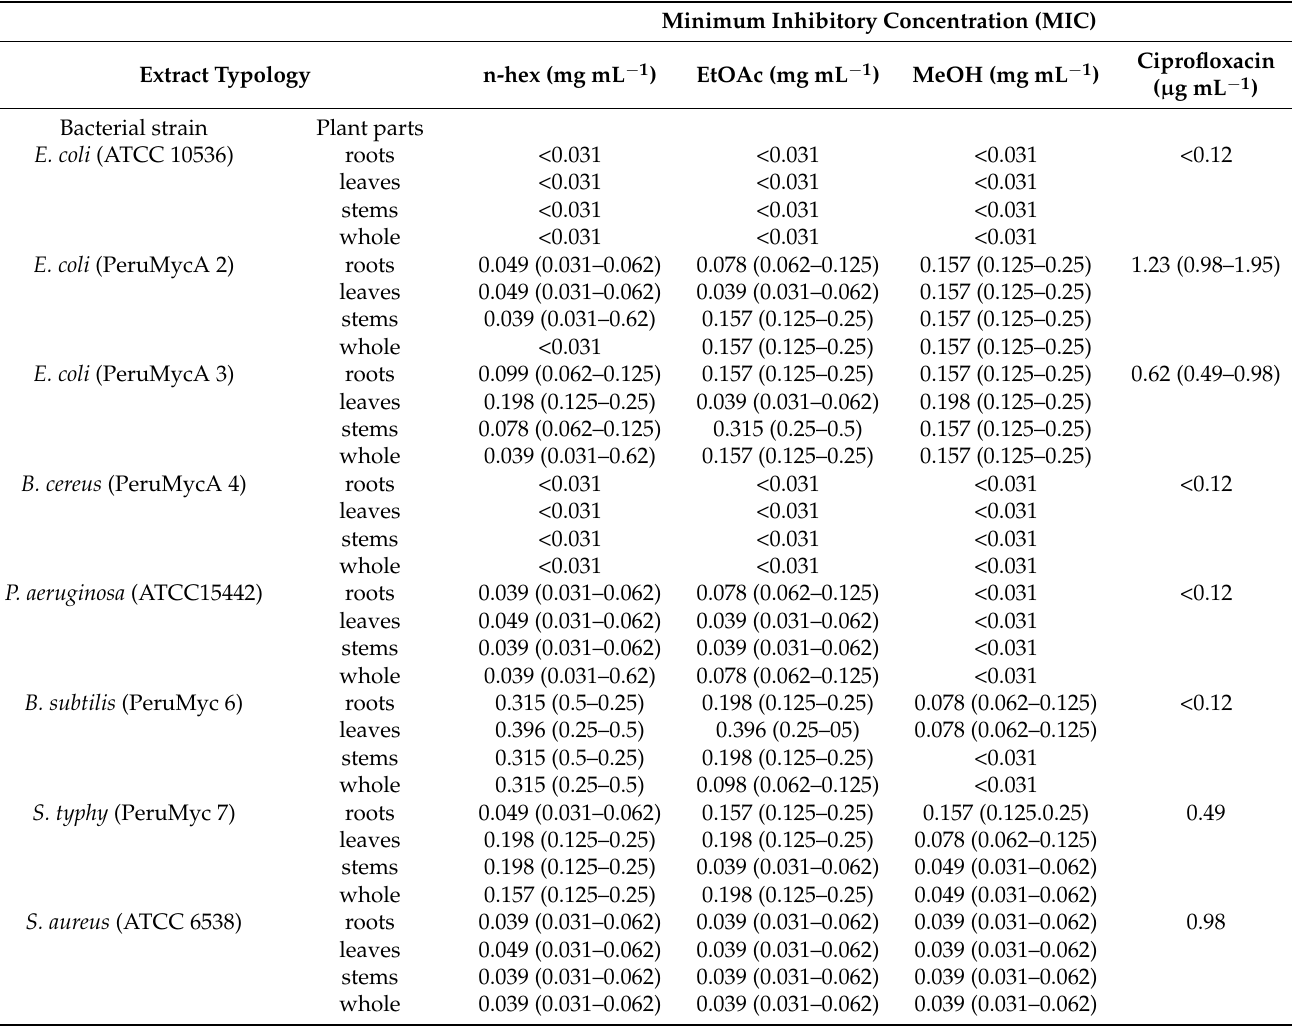
Table 3. Minimal inhibitory concentrations (MICs) of B. pilosa n-hexane, ethyl acetate and methanol extracts and ciprofloxacin against clinical Gram-positive and Gram-negative bacteria.